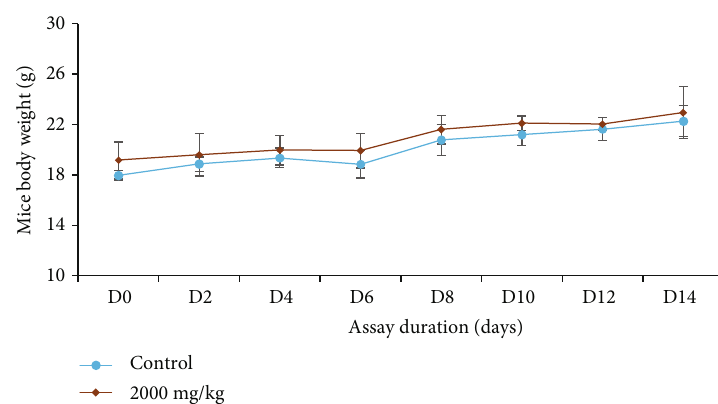
Figure 1: Evolution of mouse body weight with respect to experimentation duration.